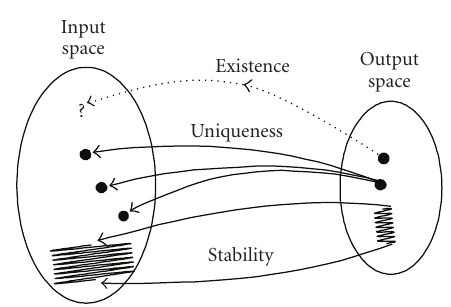
Figure 1: Concept of inverse problem and ill-posedness.